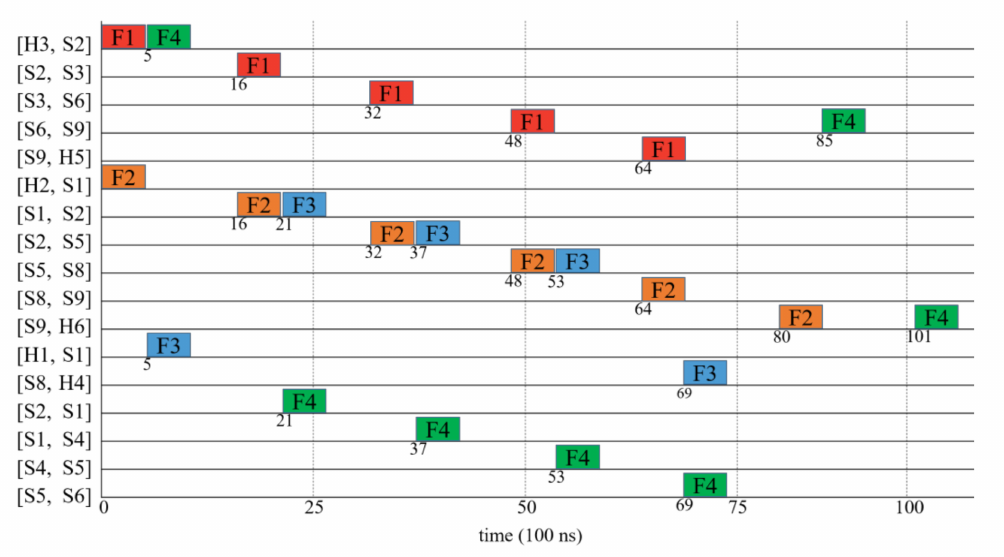
Figure 6. The timelines that flow are transmitted along the routed paths for the example shown in Figure